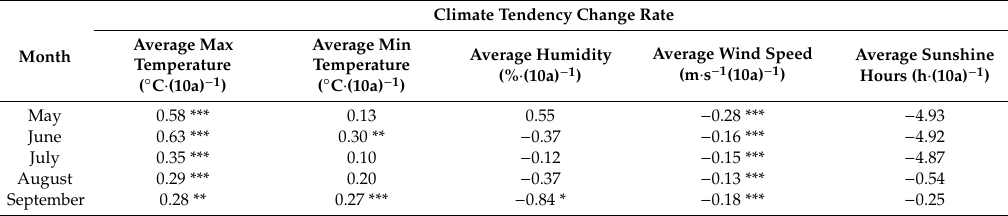
Table 1. Climatic tendency changes of each meteorological factor during the maize growing seasons of 1960–2015.